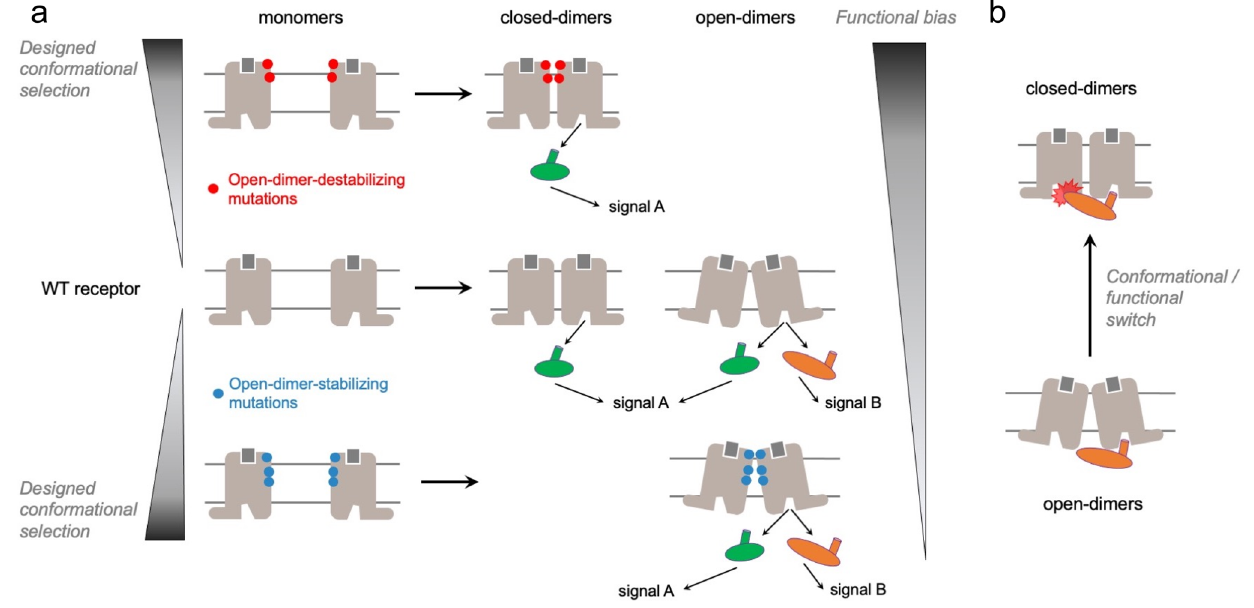
Fig. 1 | Computational modeling and design of GPCR associations with repro- grammed structures and functions using QUESTS. a Framework for the model- ing and design of speci fi c receptor quaternary active state conformations eliciting various degree of functional selectivity. The WT receptor modeled in the active state is assembled into dimers and then into ternary complex with G proteins (green) or β -arrestin (orange) to identify the distribution of quaternary con- formations and their ability to recruit intracellular signaling proteins. The dimer